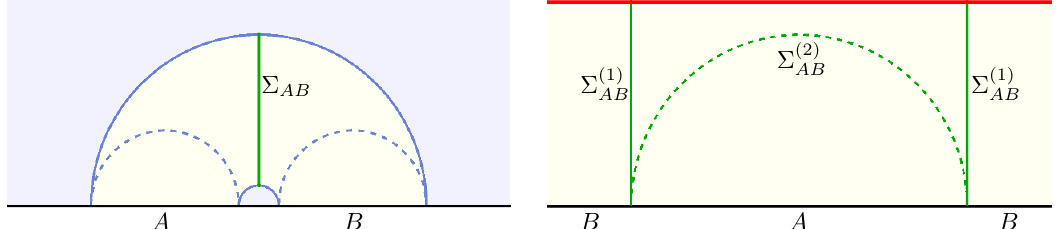
Figure 7 . Holographic entanglement of puri(cid:12)cation for two particular cases of interest: two dis- connected intervals in pure AdS and an interval and its complement in a black brane background. The corresponding entanglement wedges are shaded in yellow, while the candidates for minimal cross-section (cid:6) AB are shown in green. In the (cid:12)rst case, there is only one bottle neck in r ( AB ), for the case connected case and hence one candidate for (cid:6) AB . For large enough separations, the entanglement wedge undergoes a (cid:12)rst order transition, and becomes disconnected. In this case the entanglement of puri(cid:12)cation vanishes. In the second case there are two bottle necks in r ( AB ) and hence two candidates for the minimal cross-section (cid:6) AB . The entanglement of puri(cid:12)cation is this case is the minimum of the two, which depends on the ratio between the length of the interval and inverse